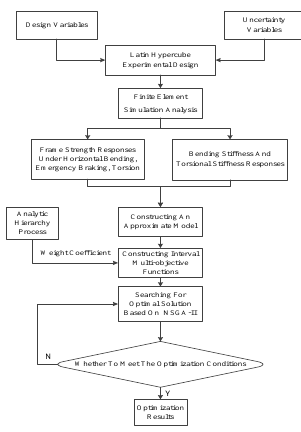
Figure 12. Interval multi-objective optimization process.